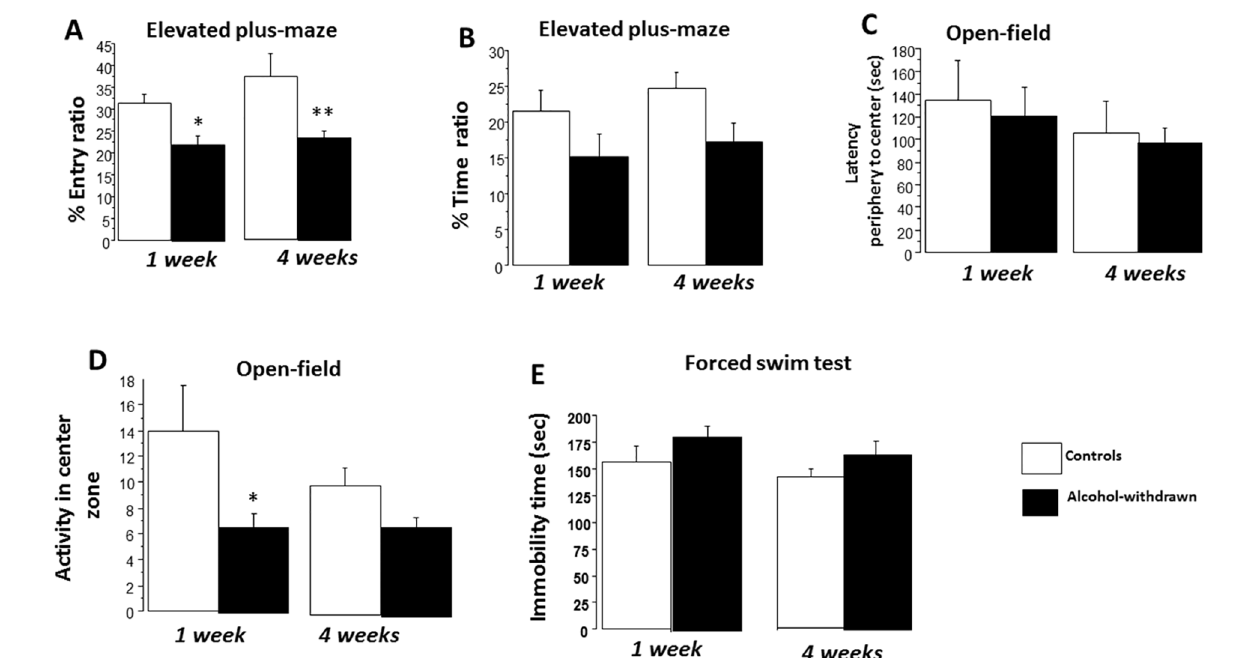
FIGURE 4 | Emotional reactivity. Results are expressed as means ± SEM. Elevated plus maze : (A) One-week and 4-week withdrawn mice ( N = 11 and 12, respectively) showed a significant decrease of entry ratio as compared to respective water controls ( N = 12 each). (B) In contrast, the decrease of time ratios observed in withdrawn groups was not statistically different from respective water control groups. Open field : One-week and 4-week withdrawn groups: N = 9 and 12, respectively; 1-week and 4-week water controls: N = 10 and 11, respectively. No significant between-group difference was observed on latency to reach the periphery of the arena to the center zone. (C) 1W withdrawn mice showed a significant mild reduction of activity in the center zone (D) . Forced-swim test : One-week and 4-week withdrawn groups: N = 10 and 12, respectively; 1-week and 4-week water controls: N = 10 and 12, respectively. No significant difference was observed on the immobility time (E). * p < 0.05 and ** p < 0.01 versus water